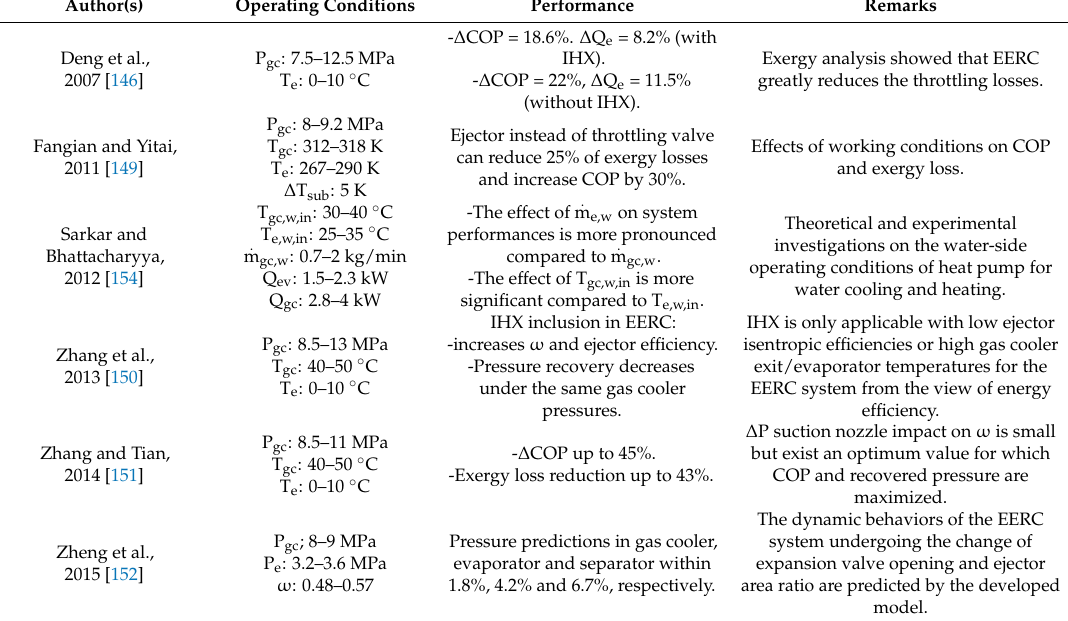
Table 5. Selection of EERC relevant theoretical studies (transcritical CO 2